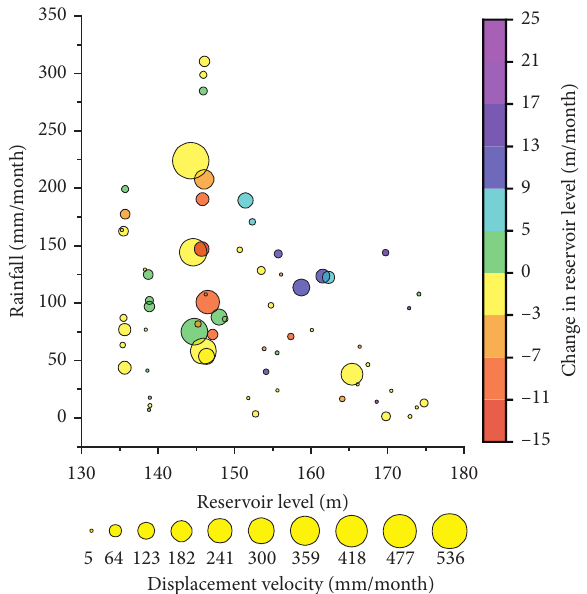
Figure 4: Correlation of displacement velocity at XD01 with the reservoir level, rainfall, and reservoir level